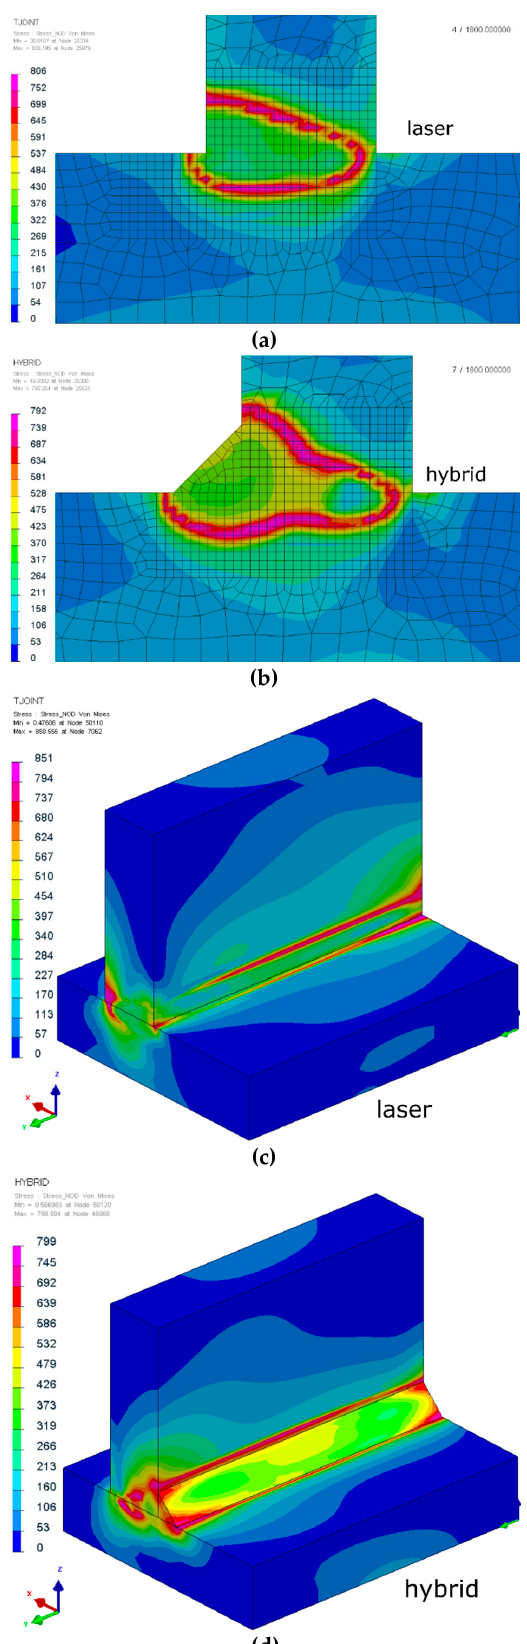
Figure 10. The von Mises stress distributions of laser ( a , c ) and hybrid ( b , d ) welded S700MC steel T- joints with a thickness of 10 mm (cross-sections were made in the half-length of the joint). Analyzing the residual stress distribution, it is clearly visible that stresses also concentrated near the fusion line (Figure 11). The values and the location of both tensile and compressive stresses were similar with some small differences. Maximal values of tensile stresses were located in the HAZ (Figure 11). In SYSWELD, it is possible to calculate cumulative plastic strains as a measure of how much yielding strain occurred. Comparing the values, they were almost the same for both methods; however, it is visible for the hybrid welding that the maximum values were located at the “bottom” of the weld (laser influence area), compared to the laser welded joints, where the areas of maximum plastic strain (about 15%) were also located at the surface of the weld (Figure 12). Figure 11. Residual stress distributions of laser and hybrid welded S700MC steel T-joints with a thickness of 10 mm (cross-sections were made in the half-length of the joint).